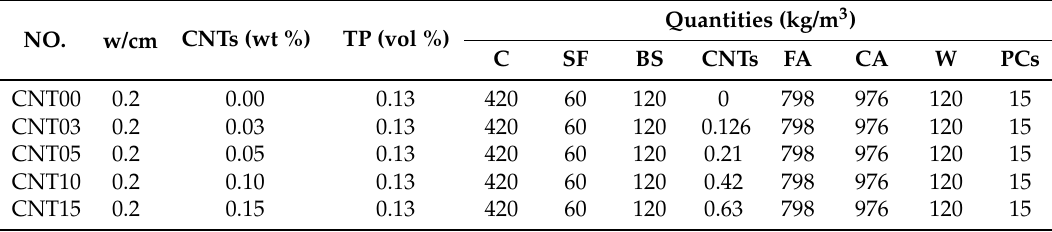
Table 3. Mixture proportions of ultra high strength concrete (UHSC) incorporating MWCNTs.